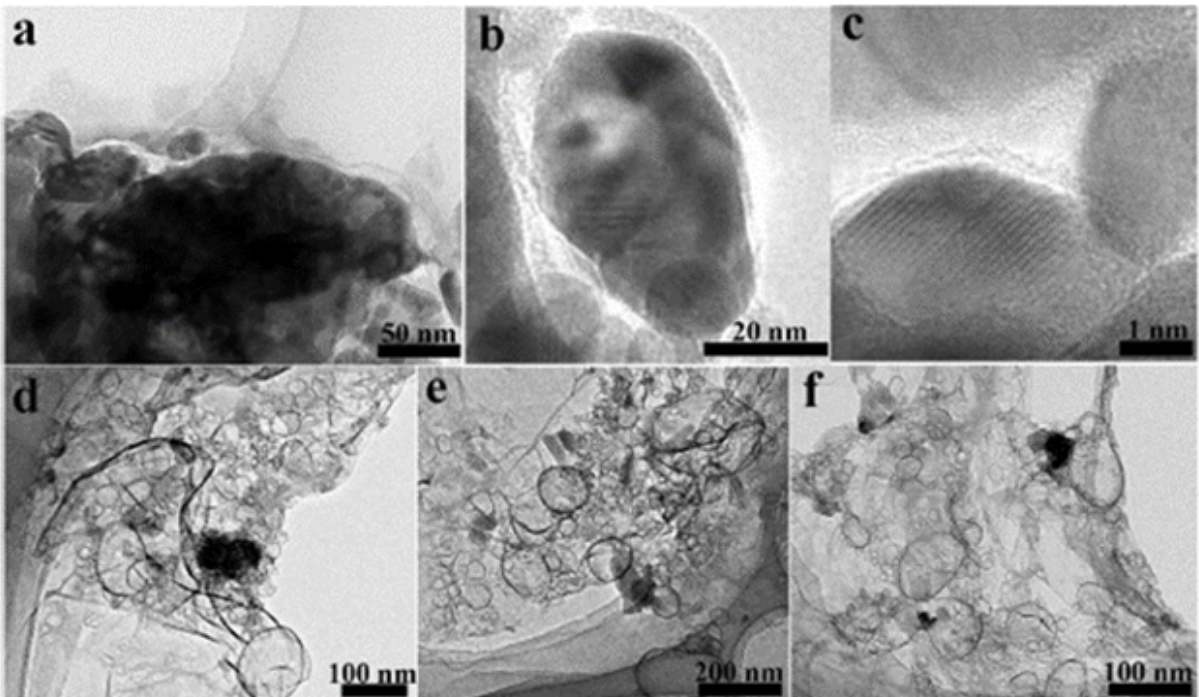
Figure 12: (a–c) TEM images of Cu powders coated by in-situ grown 3D Gr. (d–f) TEM images of porous 3D Gr after the removal of the Cu matrix with CuCl 2 solution. Reproduced from Reference [88].